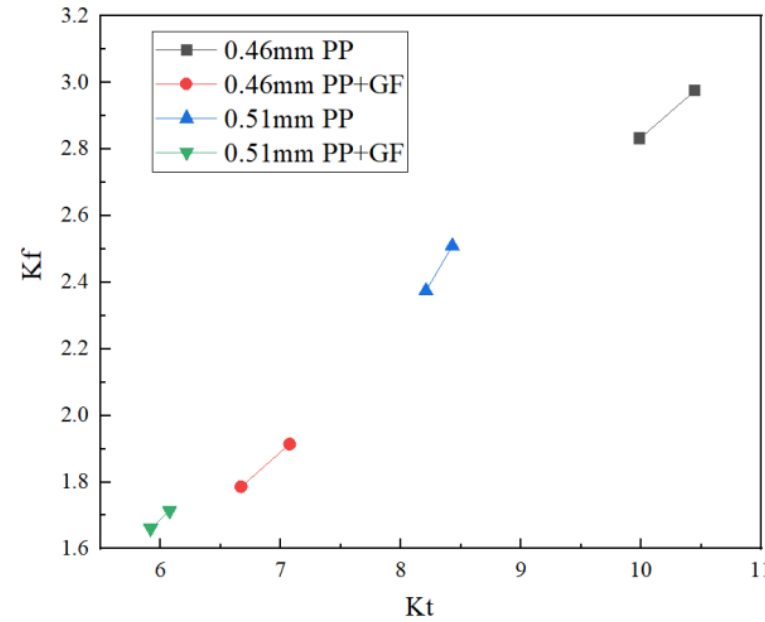
Figure 12. K t and K f relationship Figure 12. 𝐾